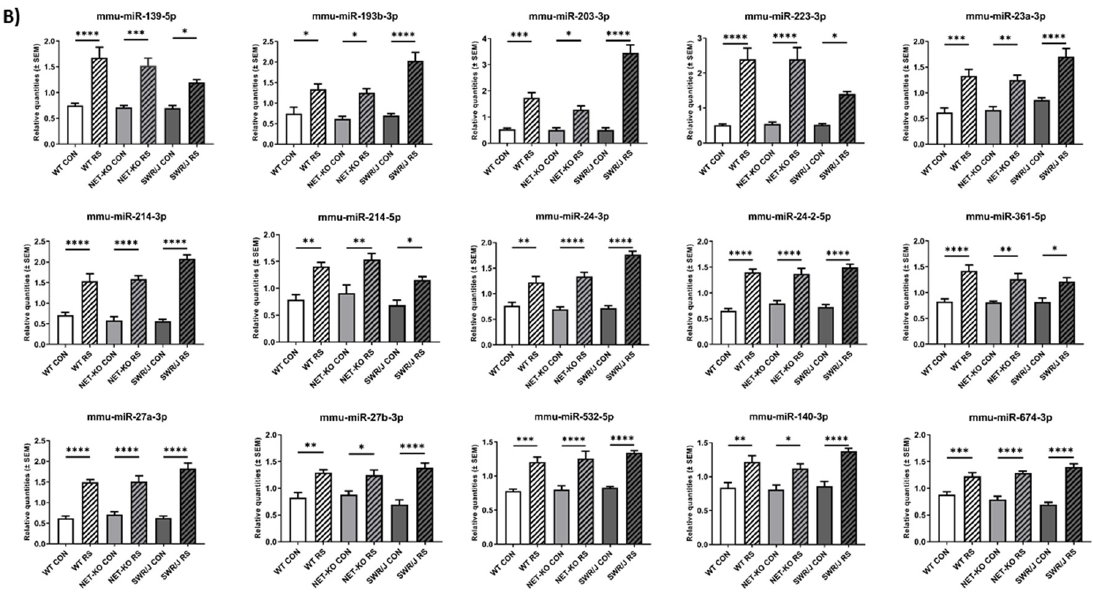
Figure 1. The level of miRNAs in the serum of three genotypes (WT, NET-KO, SWR / J) of mice under control (CON) and stress (RS) conditions. ( A ) Panel A contains all miRNAs downregulated after RS, while ( B ) panel B—miRNAs upregulated following RS. The significant changes after stress were marked on the graph: **** p < 0.0001; *** p ≤ 0.001; ** p ≤ 0.01; * p ≤ 0.05; n = 7. The remaining significant statistical di ff erences are not marked on the graphs (for clarity reasons) but are listed in the Supplementary Materials (Table